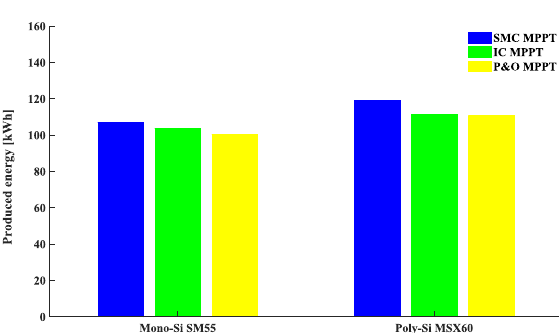
Fig. 17 Annual produced PV energy using different MPPT techniques for the Mono-Si SM55 and the Poly-Si MSX60 PV arrays